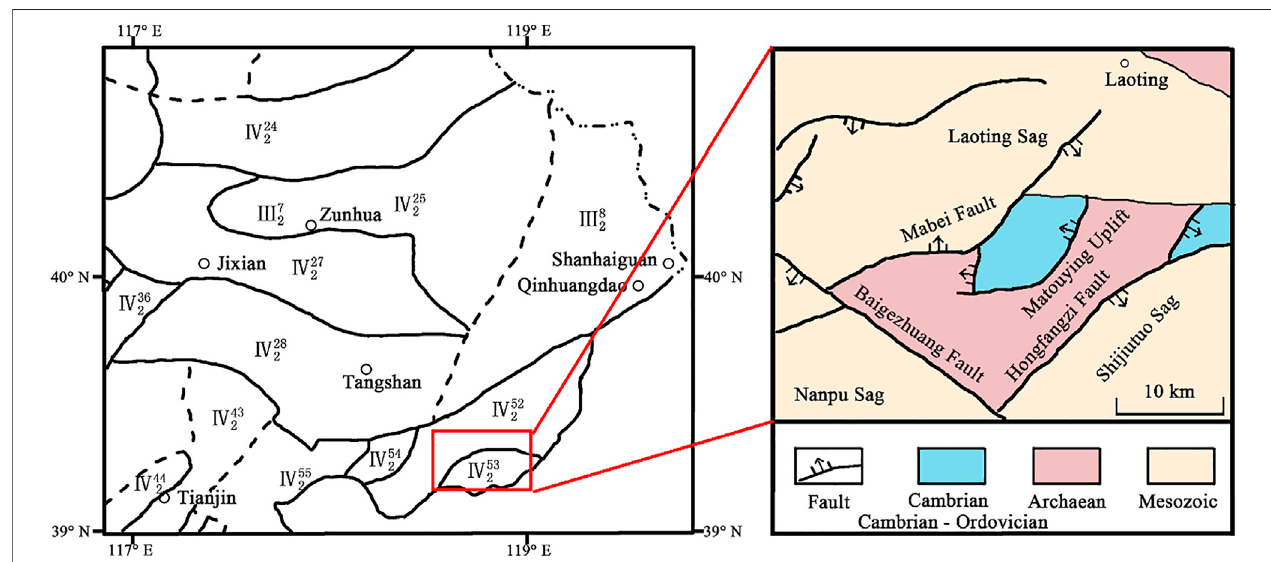
FIGURE1| Structurallocationofthestudyarea. Ⅲ 7 2 :Malanyucompoundanticline; Ⅲ 8 2 :Shanhaiguananticline; Ⅳ 24 2 :Kuanchengconcavefoldbundle; Ⅳ 25 2 :Zunhua fornix fold bundle; Ⅳ 27 2 : Jixian concave fold bundle; Ⅳ 28 2 : Kailuan depressional platform; Ⅳ 36 2 : Dachang uplift; Ⅳ 43 2 : Panzhuang depression; Ⅳ 44 2 : Dacheng depression; Ⅳ 52 Ⅳ 53 Ⅳ 54 Ⅳ 55 2 : Nanpu uplift; 2 : Matouying uplift; 2 : Baigezhuang uplift; 2 : Beitang